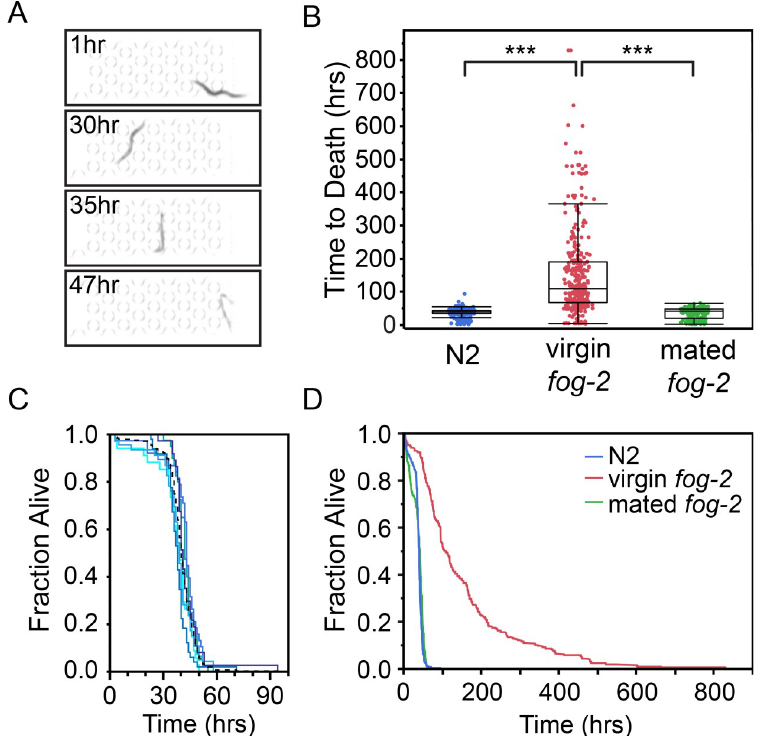
Fig 4. Dietary stress. (A) Images of N2 animal at 1, 30, 35, and 47hrs showing the characteristic “bag of worms” death. (B) Time to death for animals in M9 buffer (Number of animals = 244 (N2), 327 ( fog-2 ( q71 )), 263 (mated fog-2 ( q71 ))). ��� signifies p < 0.0001. The N2 versus mated fog-2 comparison is not significantly different, with a p = 0.87. (C) N2 Lifespan curves in M9 from day 1 of adulthood. Each solid line is one of six different sample lanes representing between 34 and 49 individuals. The black dotted line represents the curve of all N2 animals. No significant differences are seen between replicates. (D) Lifespan curves in M9 from day 1 of adulthood. Log Rank p < 0.0001.